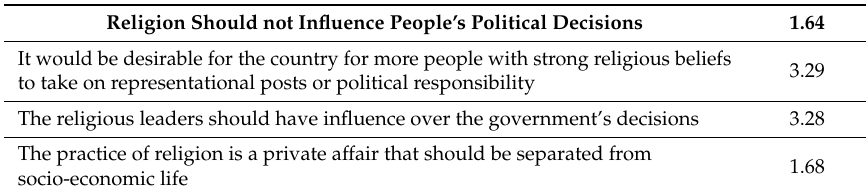
Table 11. Religion and politics (mean scores: 1 = strongly agree, 5 = strongly